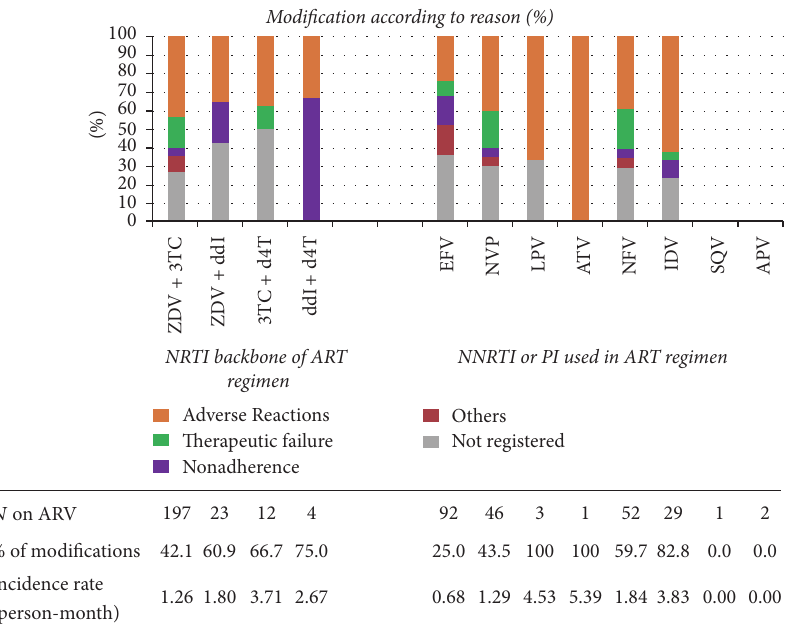
Figure 2: Frequency of ARV modifications according to reason for modification. Values on table shows the total of each combination prescribed, the frequency of modification according to each combination used, and the incidence rate of modifications in person-months. The NRTI backbone is always used combined with one of those NNRTIs or